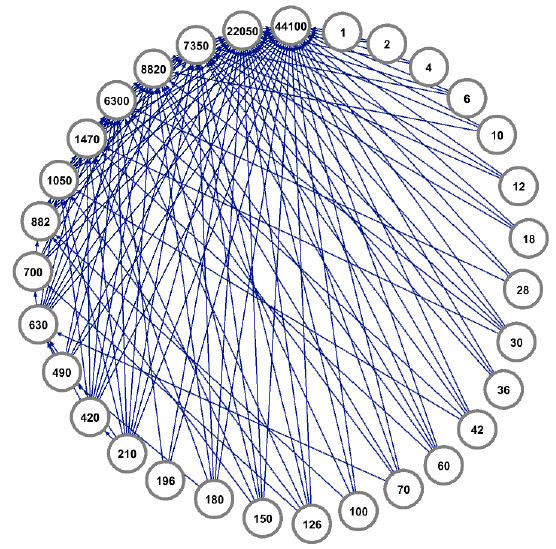
Figure 2. Divisor graph for λ =